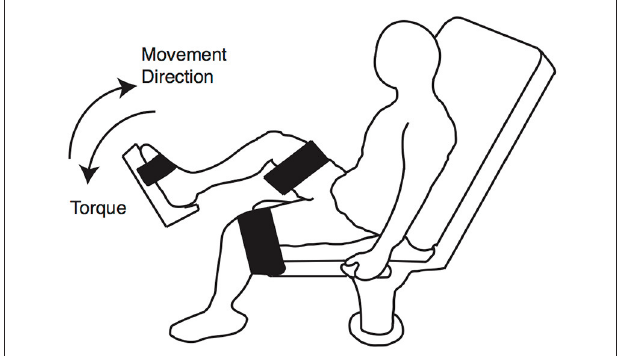
FIGURE 3 | MVIC and eccentric contraction positioning. Subjects were seated on a dynamometer with the knee and hip joints at approximately 90 ◦ . Both legs were secured using